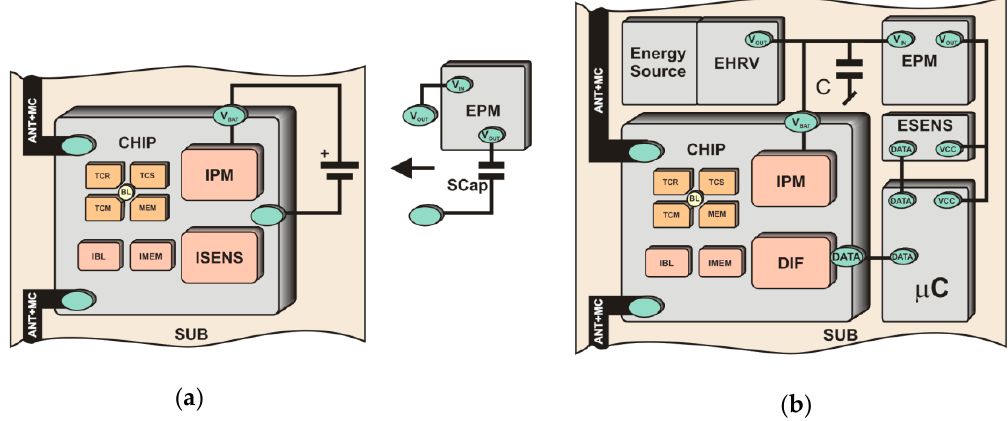
Figure 4. Different concepts of autonomous RFID sensors. ( a ) Construction based on semi-passive transponder; ( b ) Construction based on semi-passive transponder and external energy harvester. EPM—external management circuit of power supply and battery charging; EHRV—external energy harvester; SCap—supercapacitor; µ C—microcontroller; Energy Source—transducer of light radiation, thermal radiation, mechanical vibrations, electromagnetic field of public radiocommunication systems, etc.